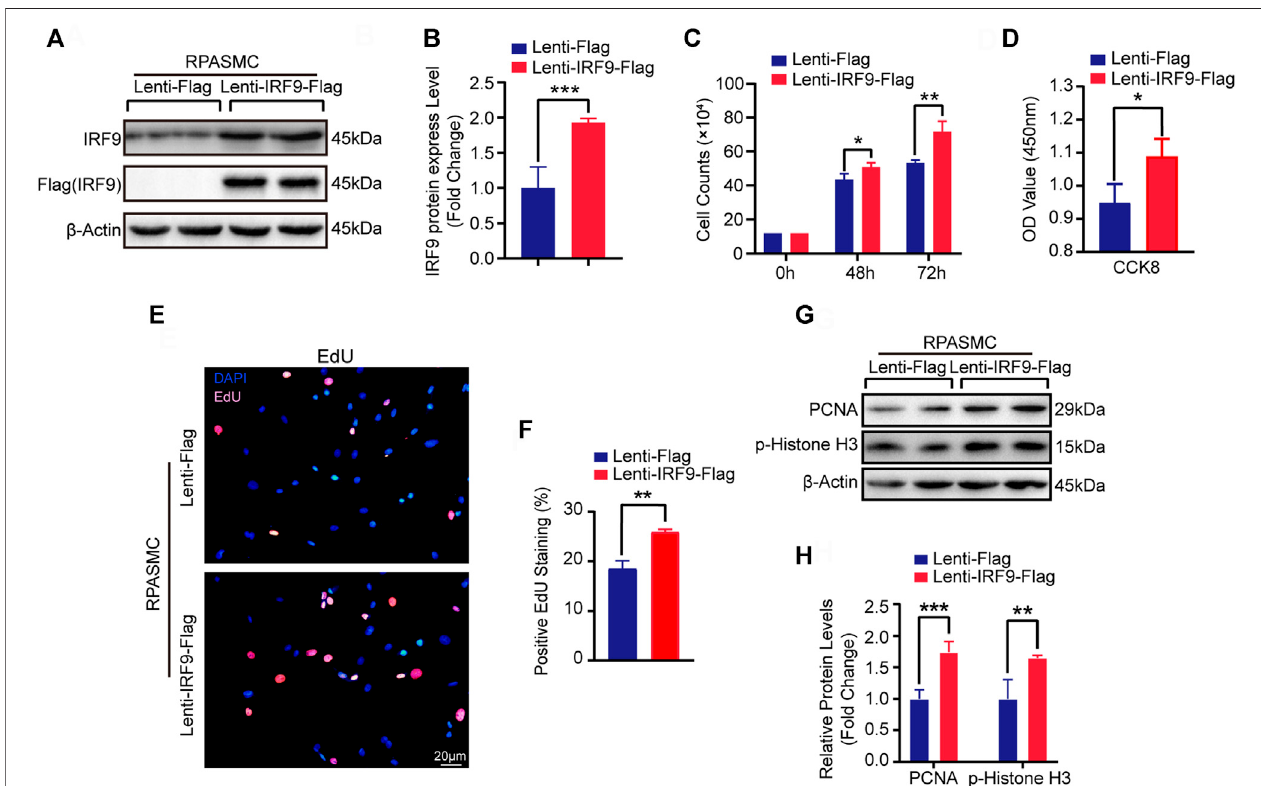
FIGURE 2 | IRF9 overexpression increased the proliferation of RPASMCs. (A) After overexpressing IRF9 (Lenti-IRF9-Flag) or not (Lenti-Flag) in RPASMCs, the expressionlevelofIRF9andtheexogenouslabelproteinFlagwasdeterminedusingwesternblot( n (cid:2) 3independentexperiments). (B) TheexpressionlevelsofIRF9were normalized to β -Actin and quanti fi ed ( n (cid:2) 3 independent experiments). (C) Cell numbers were counted at indicated time point after IRF9-overexpressing or not in RPASMCsundernormoxiacondition( n (cid:2) 3independent experiments). (D) CCK-8 assaywasperformed andtheabsorbance(ODvalue)at 450 nm wasmeasured to shows the proliferation activity of Lenti-Flag and Lenti-IRF9-Flag RPASMCs under normoxia condition ( n (cid:2) 3 independent experiments). (E) EdU incorporation assay shows the ratio of cells incorporated EdU in Lenti-Flag and Lenti-IRF9-Flag RPASMCs under normoxia condition, in which nuclei were stained with DAPI (blue) and EdU merged with DAPI appears pink. Scale bar (cid:2) 20 μ m. (F) The positive EdU staining rates were quanti fi ed ( n (cid:2) 3 independent experiments). (G) The protein levels of proliferation biomarkers PCNA and p-Histone H3 were determined using western blot after overexpressing IRF9 or not in RPASMCs under normoxia condition. (H) The expression levels of PCNA and p-Histone H3 were quanti fi ed and normalized to β -Actin ( n (cid:2) 3 independent experiments). Values are means ± SD; *** p < 0.001, ** p < 0.01, * p < 0.05.